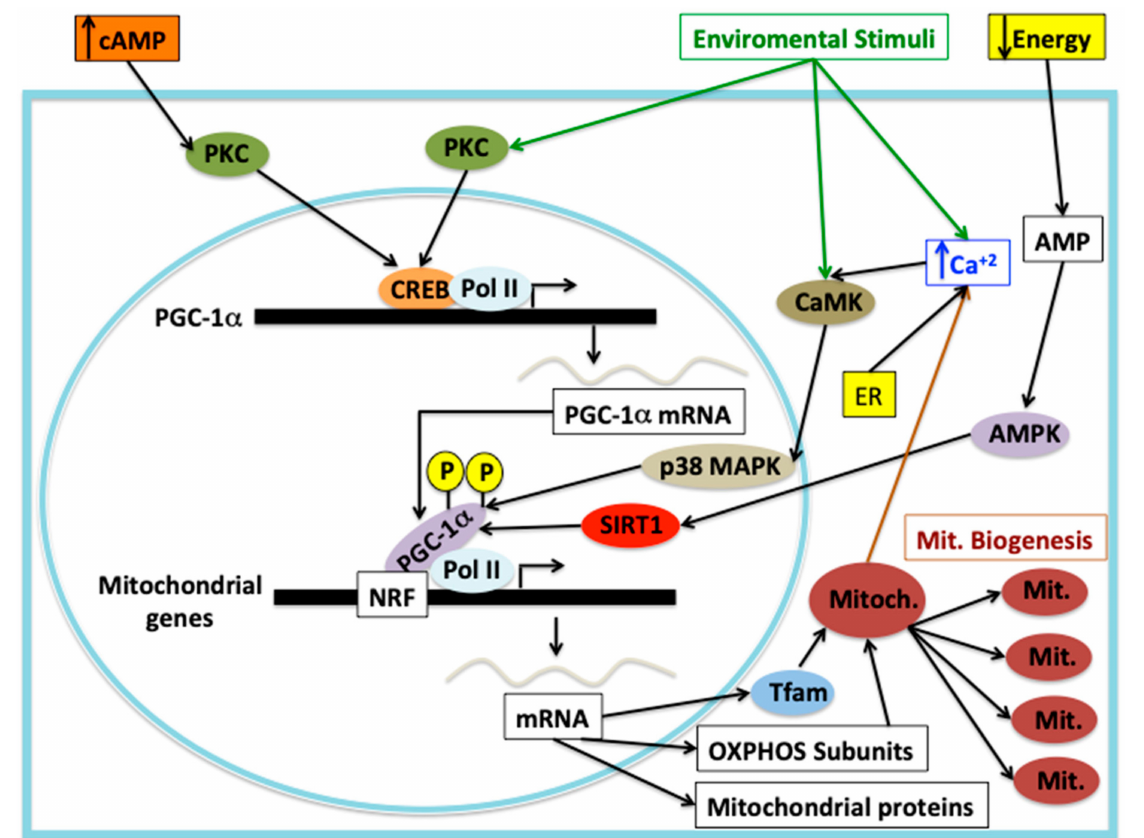
Figure 5. The ARE-NRF2-KEAP1 signaling pathway. Several factors (phase II inducers) can activate the ARE-NRF2-KEAP1 pathway to trigger antioxidant enzymes expression (phase II gene products). The pathway starts with the signaling from phase II inducers, such as pharmaceuticals, oxidants, antioxidants, electrophile compounds, dietary compounds, and intracellular signals which can be sensed by cysteine residues on the KEAP1 polypeptide, which release NRF2 to be translocated to the nucleus and bind to the ARE sequences in the gene promoter of antioxidant enzyme encoding genes to start the transcriptional activation of those genes and mount a cellular antioxidant defense response. Mitochondrial ROS/RSN or hydrogen peroxide can also signal on KEAP1 to release NRF2 and start the cellular antioxidant